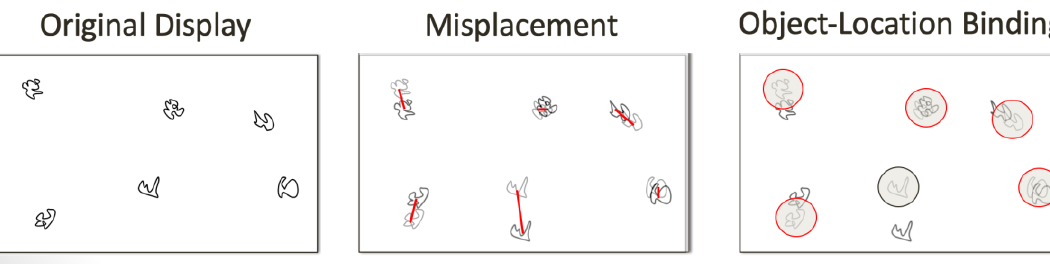
Figure 2. Spatial reconstruction task error metrics.